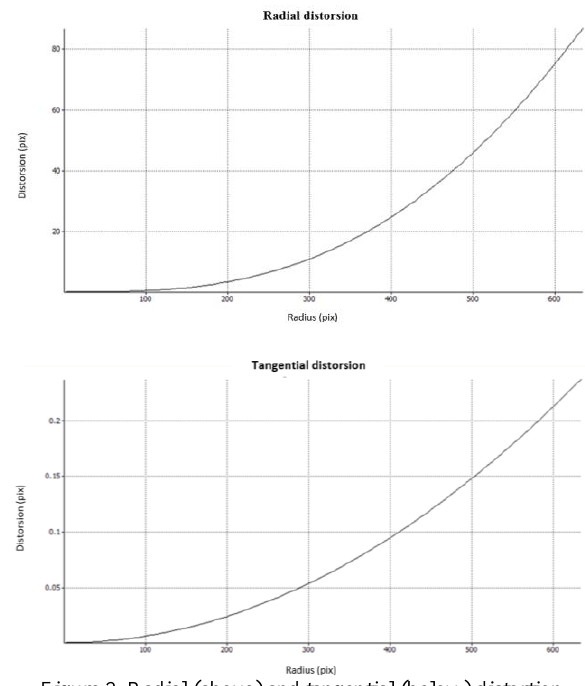
Figure 2. Radial (above) and tangential (below) distortion curves